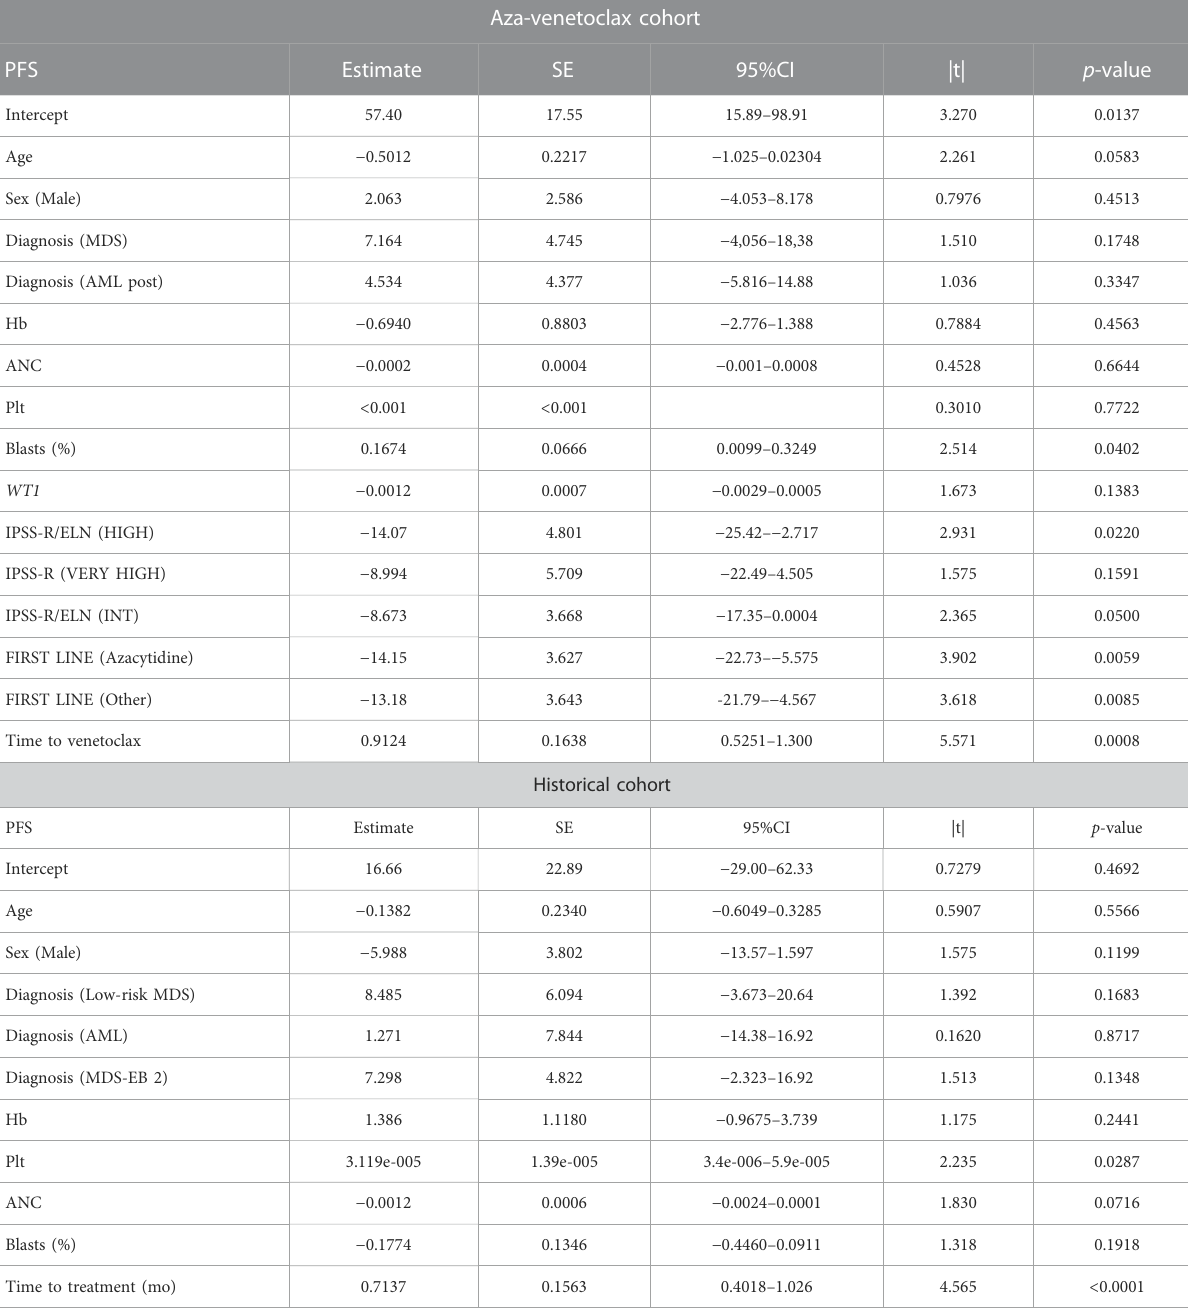
TABLE 3 Univariate